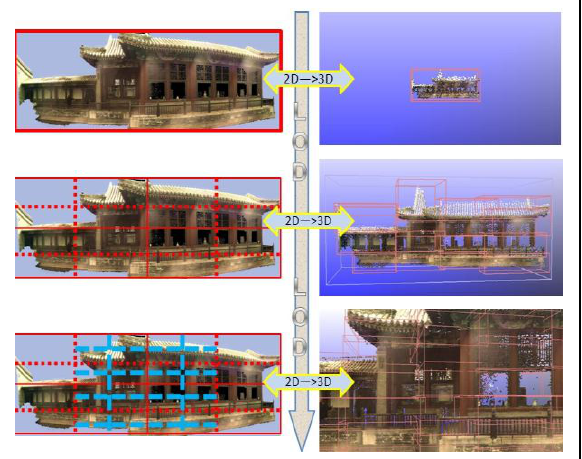
Figure 1 The Data partition of QMBB-tree spatial